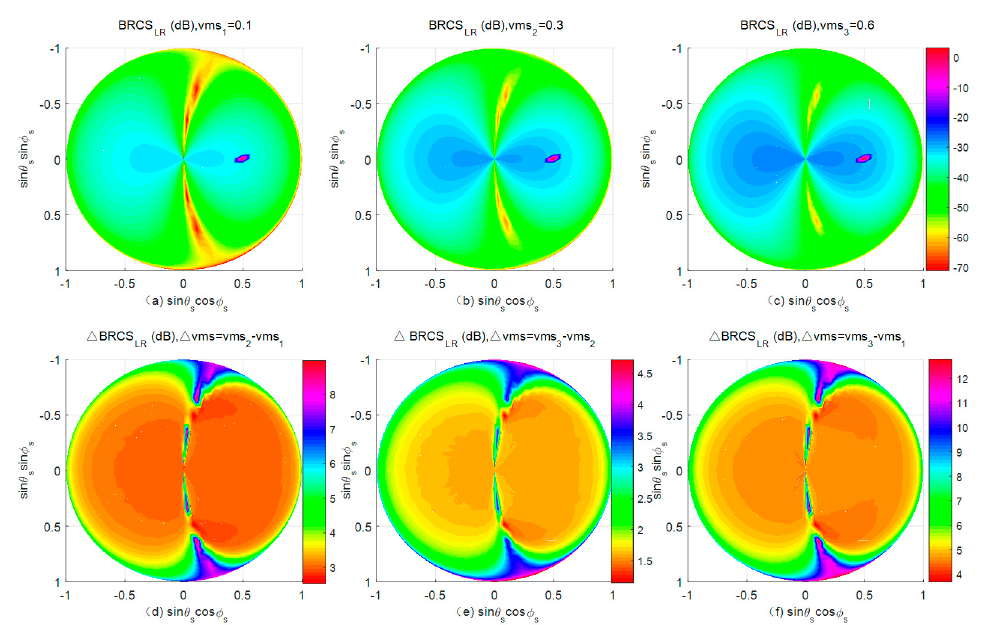
Figure 8. BRCS for different soil moisture contents ( a – c ) and the BRCS differences for different soil moisture differences ( d – f ) at LR polarization.